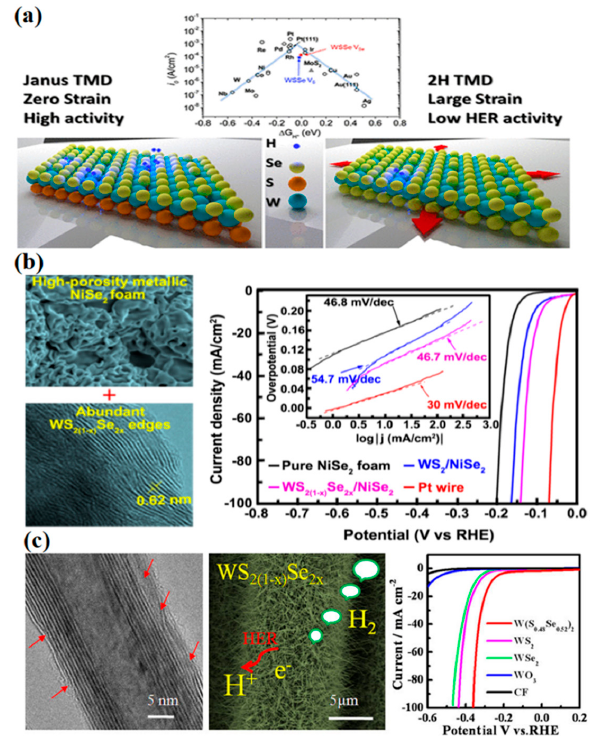
Figure 7. ( a ) Schematic for WSSe with ∆ G H “volcano” plot, the illustration shows that strain free Janus TMDs possess better HER activities. Reprinted with permission from [125], copyright (2018), American Chemical Society. ( b ) TEM of WS 2(1 − x) Se 2x particles with a 3D porous metallic NiSe2 foam and corresponding polarization curves recorded on WS 2(1 − x) Se 2x /NiSe 2 foam. ( c ) TEM of WS 2(1 − x) Se 2x nanotubes and corresponding polarization curves recorded on WS 2(1 − x) Se 2x in comparison with WS 2 . Reprinted with permission from Reference [67], copyright (2014), American Chemical